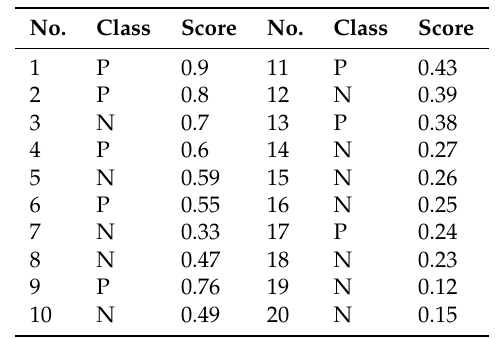
Table 3. An example of a testing dataset along with the actual class label and scores (i.e., the predicted probability of being positive